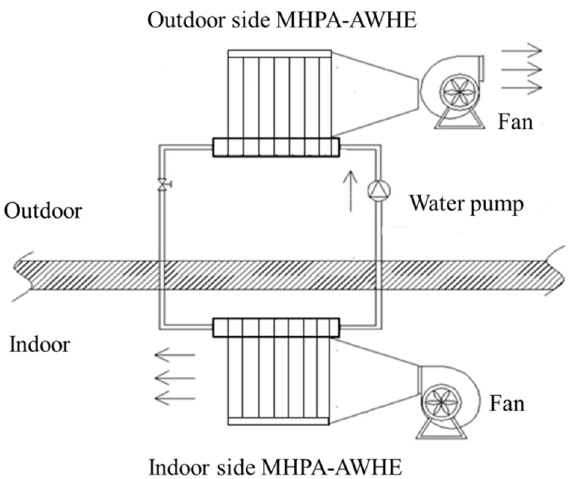
Figure 1. Split natural cooling system for data center.